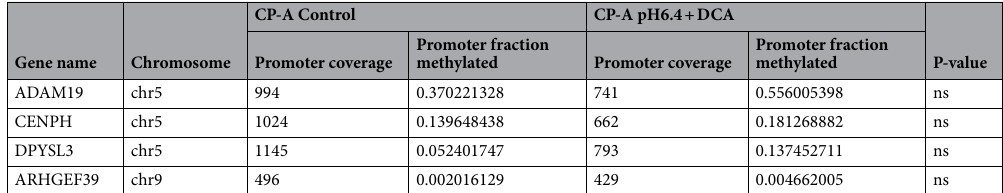
Table 1. Comparison of methylation rates of the four genes between before and after treatment with acid and DCA in